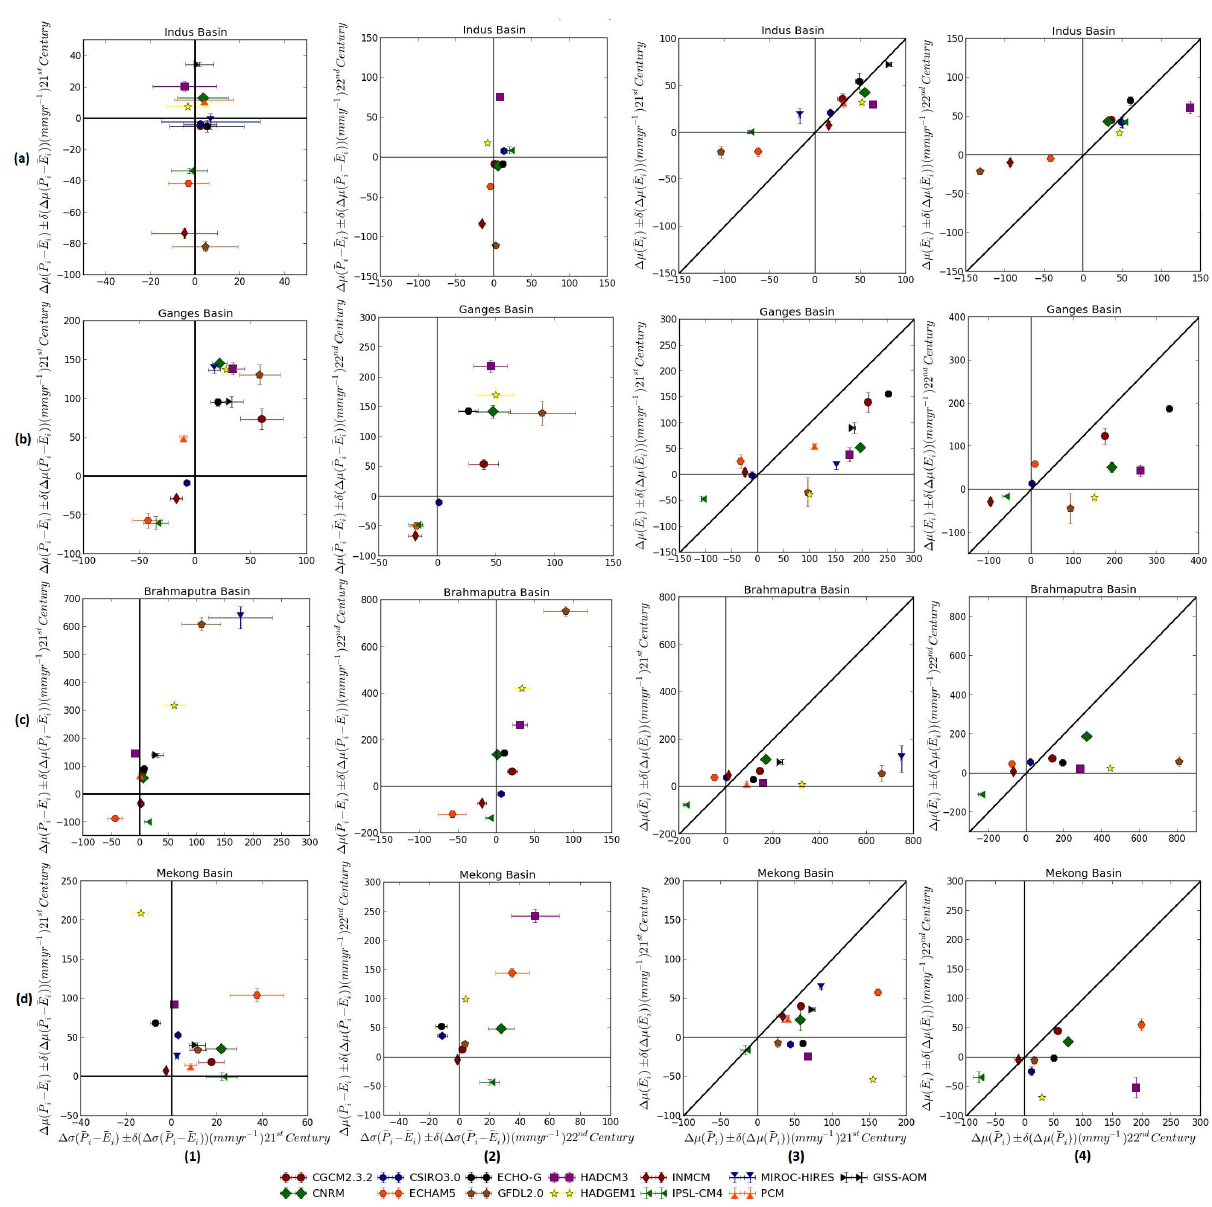
Fig. 3. (a1) – (d4) Projected changes for: (row a) Indus Basin (row b) Ganges Basin, (row c) Brahmaputra Basin, (row d) Mekong Basin: (column 1) P − E against its variability for 21st century climate (2061–2100), (column 2) P − E against its variability for 22nd century climate (2161–2200), (column 3) E against P for 21st century climate (2061–2100), (column 4) E against P for 22nd century climate (2161–2200). Markers show mean annual simulated basin-integrated quantities, whereas lines show their 95% confidence intervals.